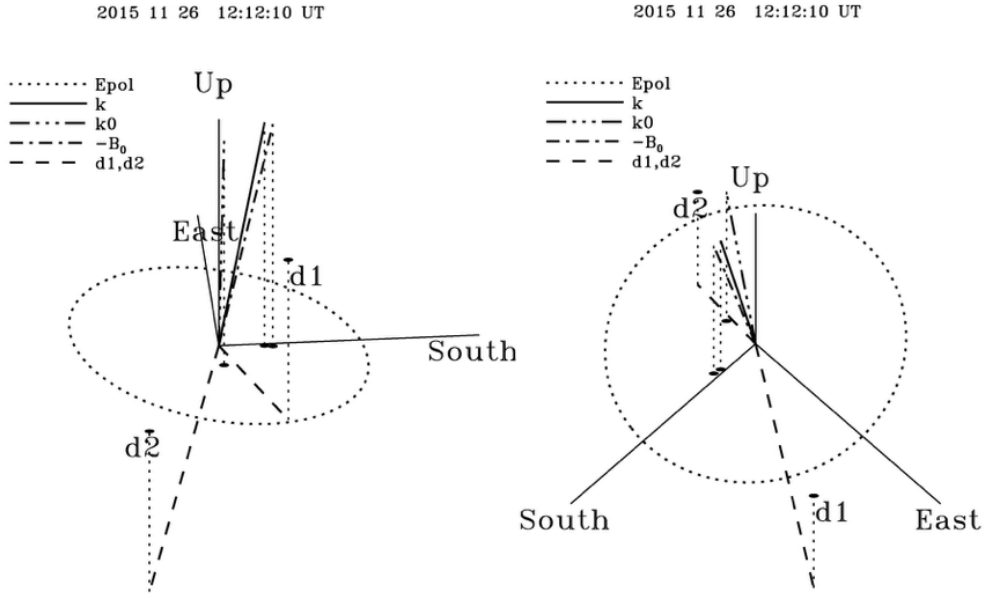
Figure 6. Direction of the pump wave vector ( k ) at an altitude of 352km (12:12:10UT on 26 November 2015, corresponding to the plasma profile in Fig. 4). See Fig. 3 for a description of the diagram. The DOA calculations were done with f p = 5 . 00 and f e = 1 . 29MHz at the CASSIOPE